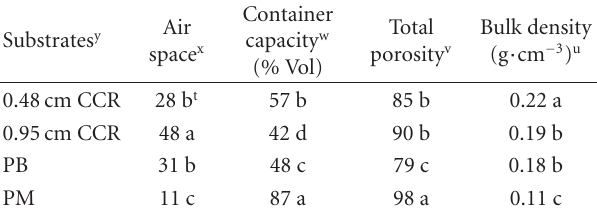
Table 1: Physical properties of clean chip residual, pine bark, and peatmoss substrates.